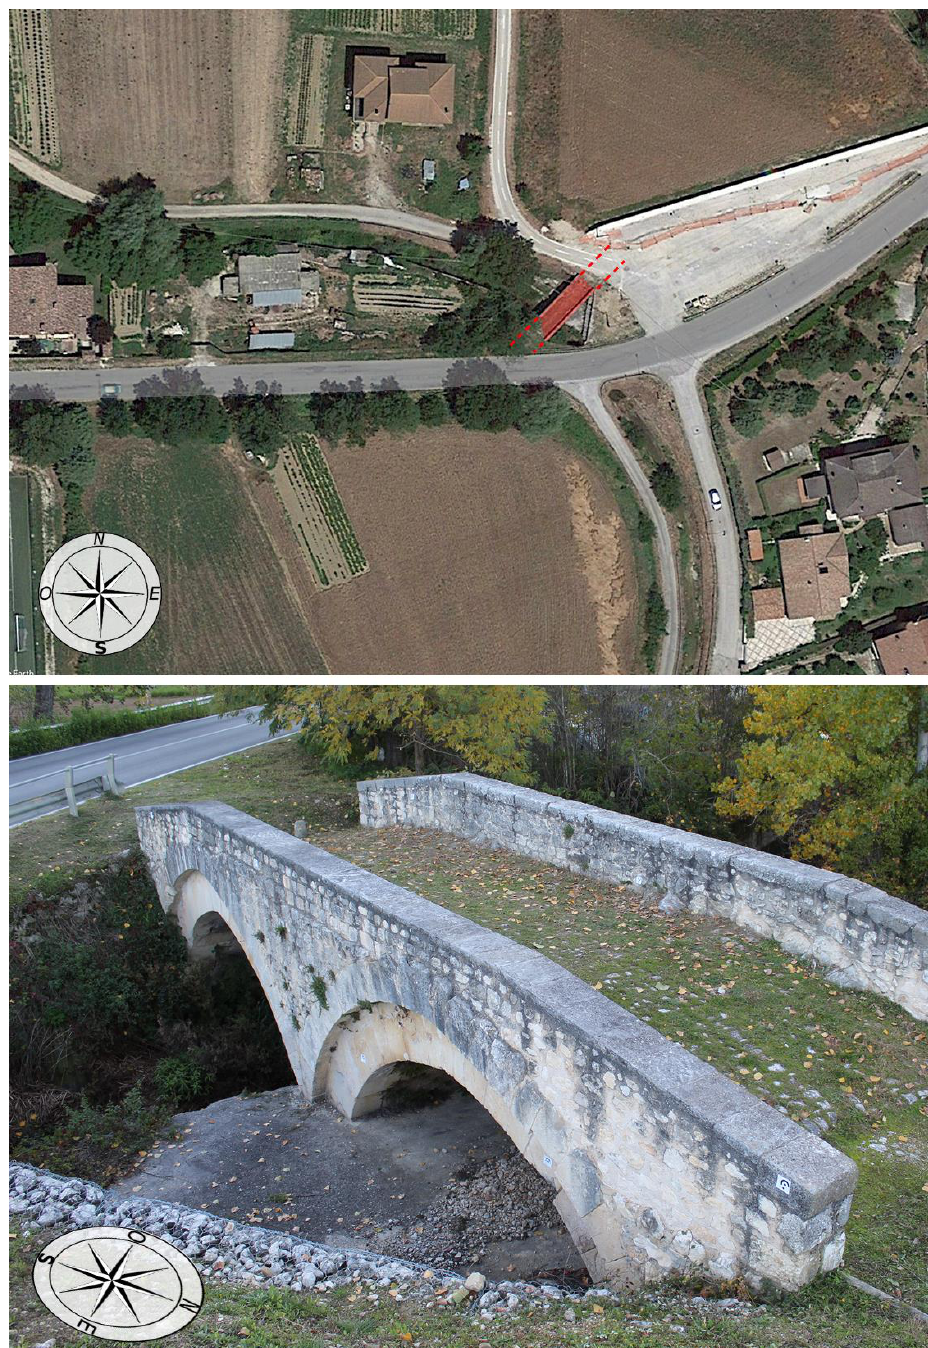
Figure 8. Bridge in the Cerro locality, in the territory of the municipality of Fossa, L’Aquila.